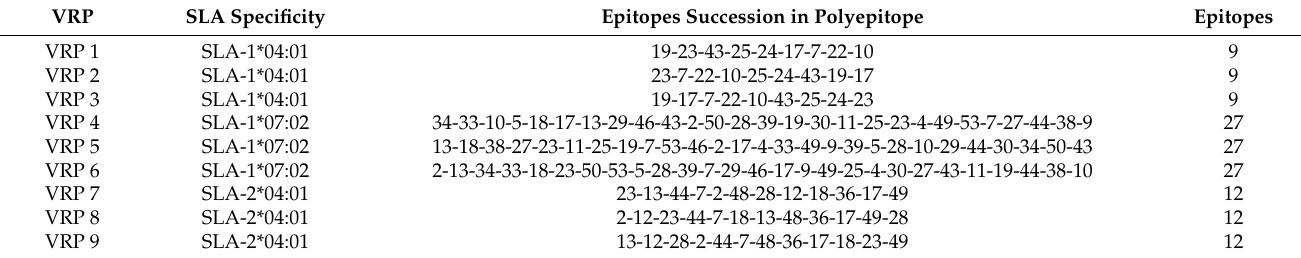
Table 3. Polyepitopes assembled according to the SLA specificity of the